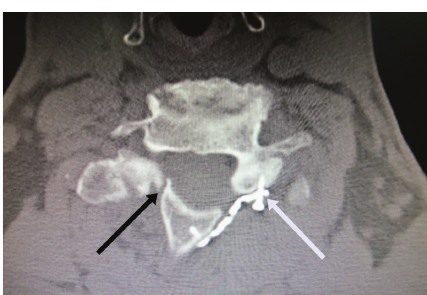
Figure 6: Axial CT scan at 6 months demonstrates screw back out (white arrow) and nonunion on the hinge side (black arrow) (no bone bridge at both dorsal and ventral cortices). There was no reclosure of